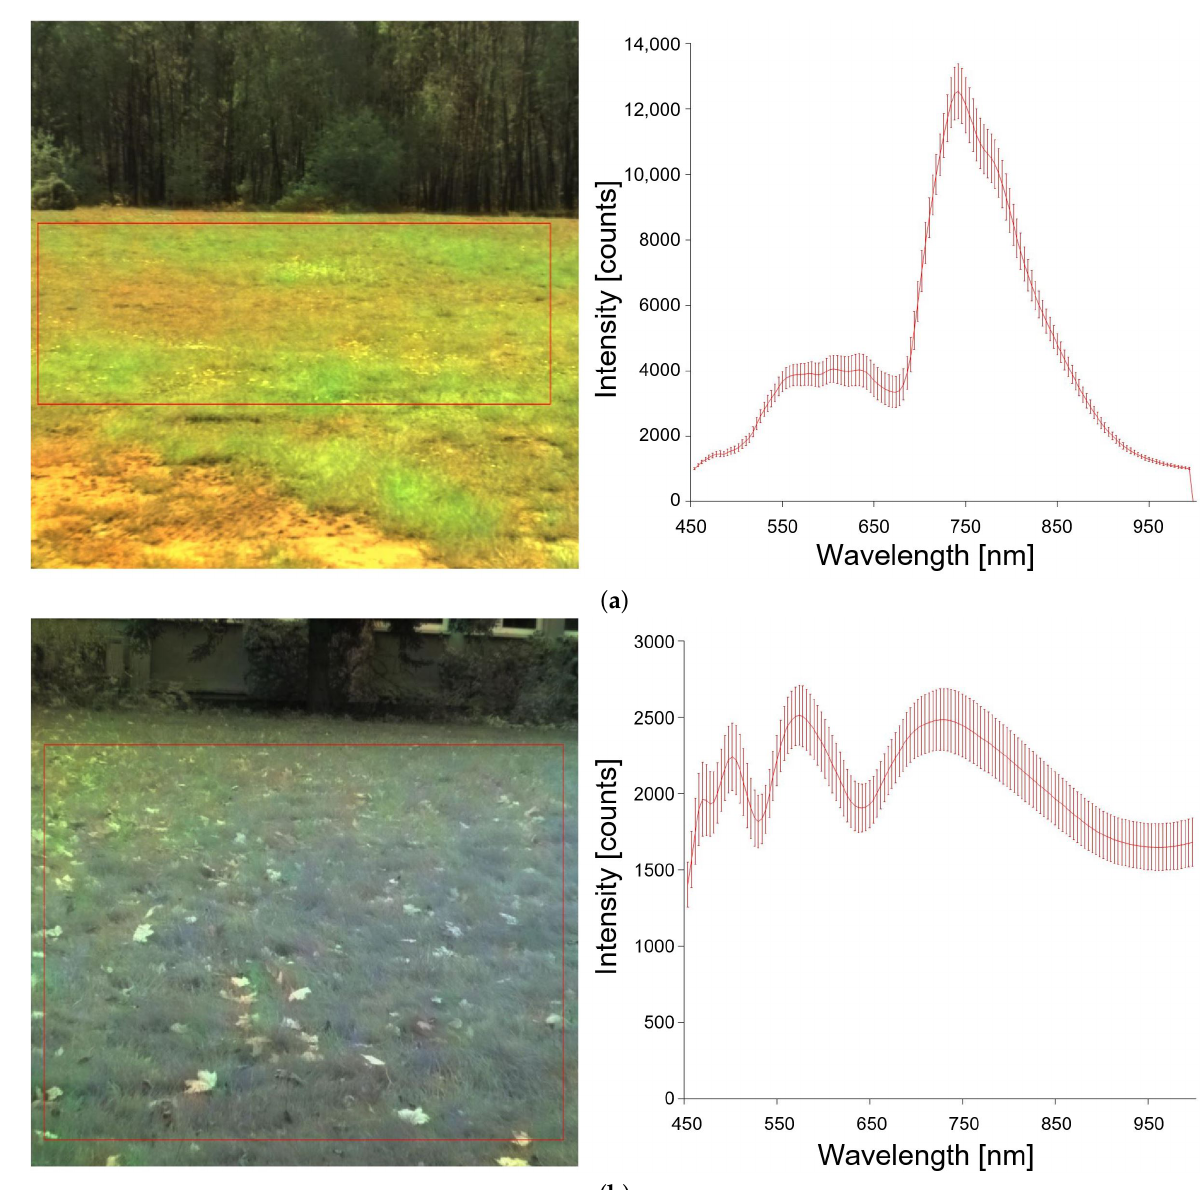
Figure 7. Grass at a different time of year: ( a ) grass in May, ( b ) grass in October. To classify an unknown area, we need to find the nearest area with a known class membership [37]. For this purpose, we have to define a metric to compare the distance between spectral distributions. In our algorithm, we adopted methods of comparing histograms